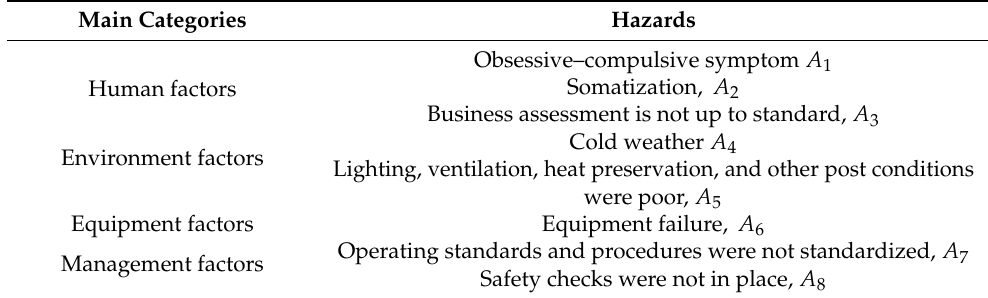
Table 10. Hazard factors of “the assistant watchman did not appear as required”